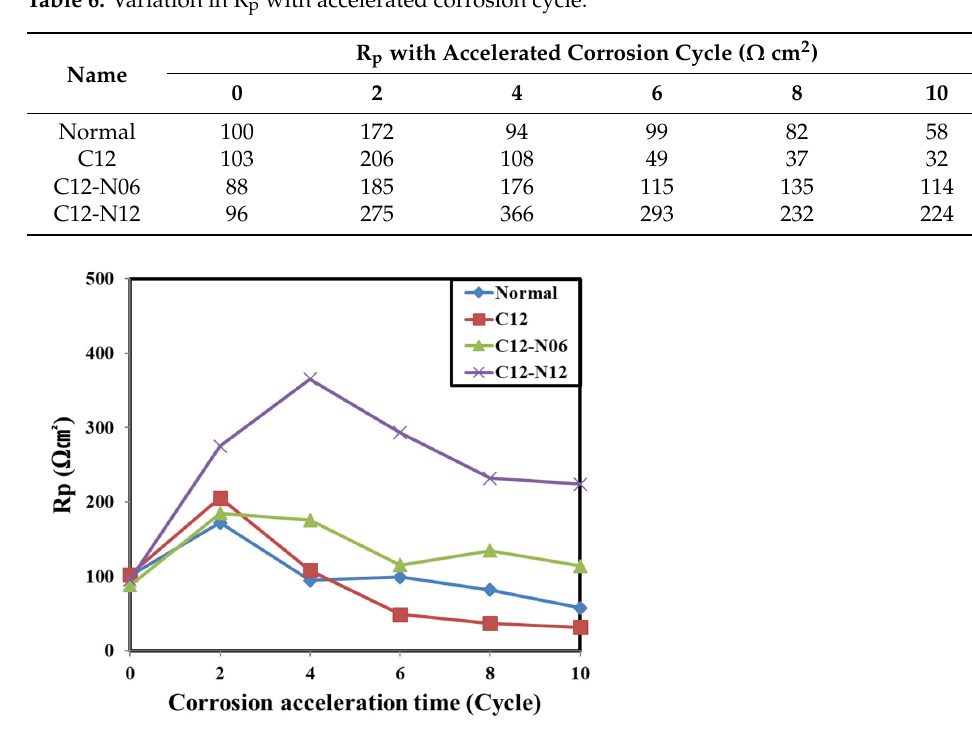
Table 6. Variation in R p with accelerated corrosion cycle.